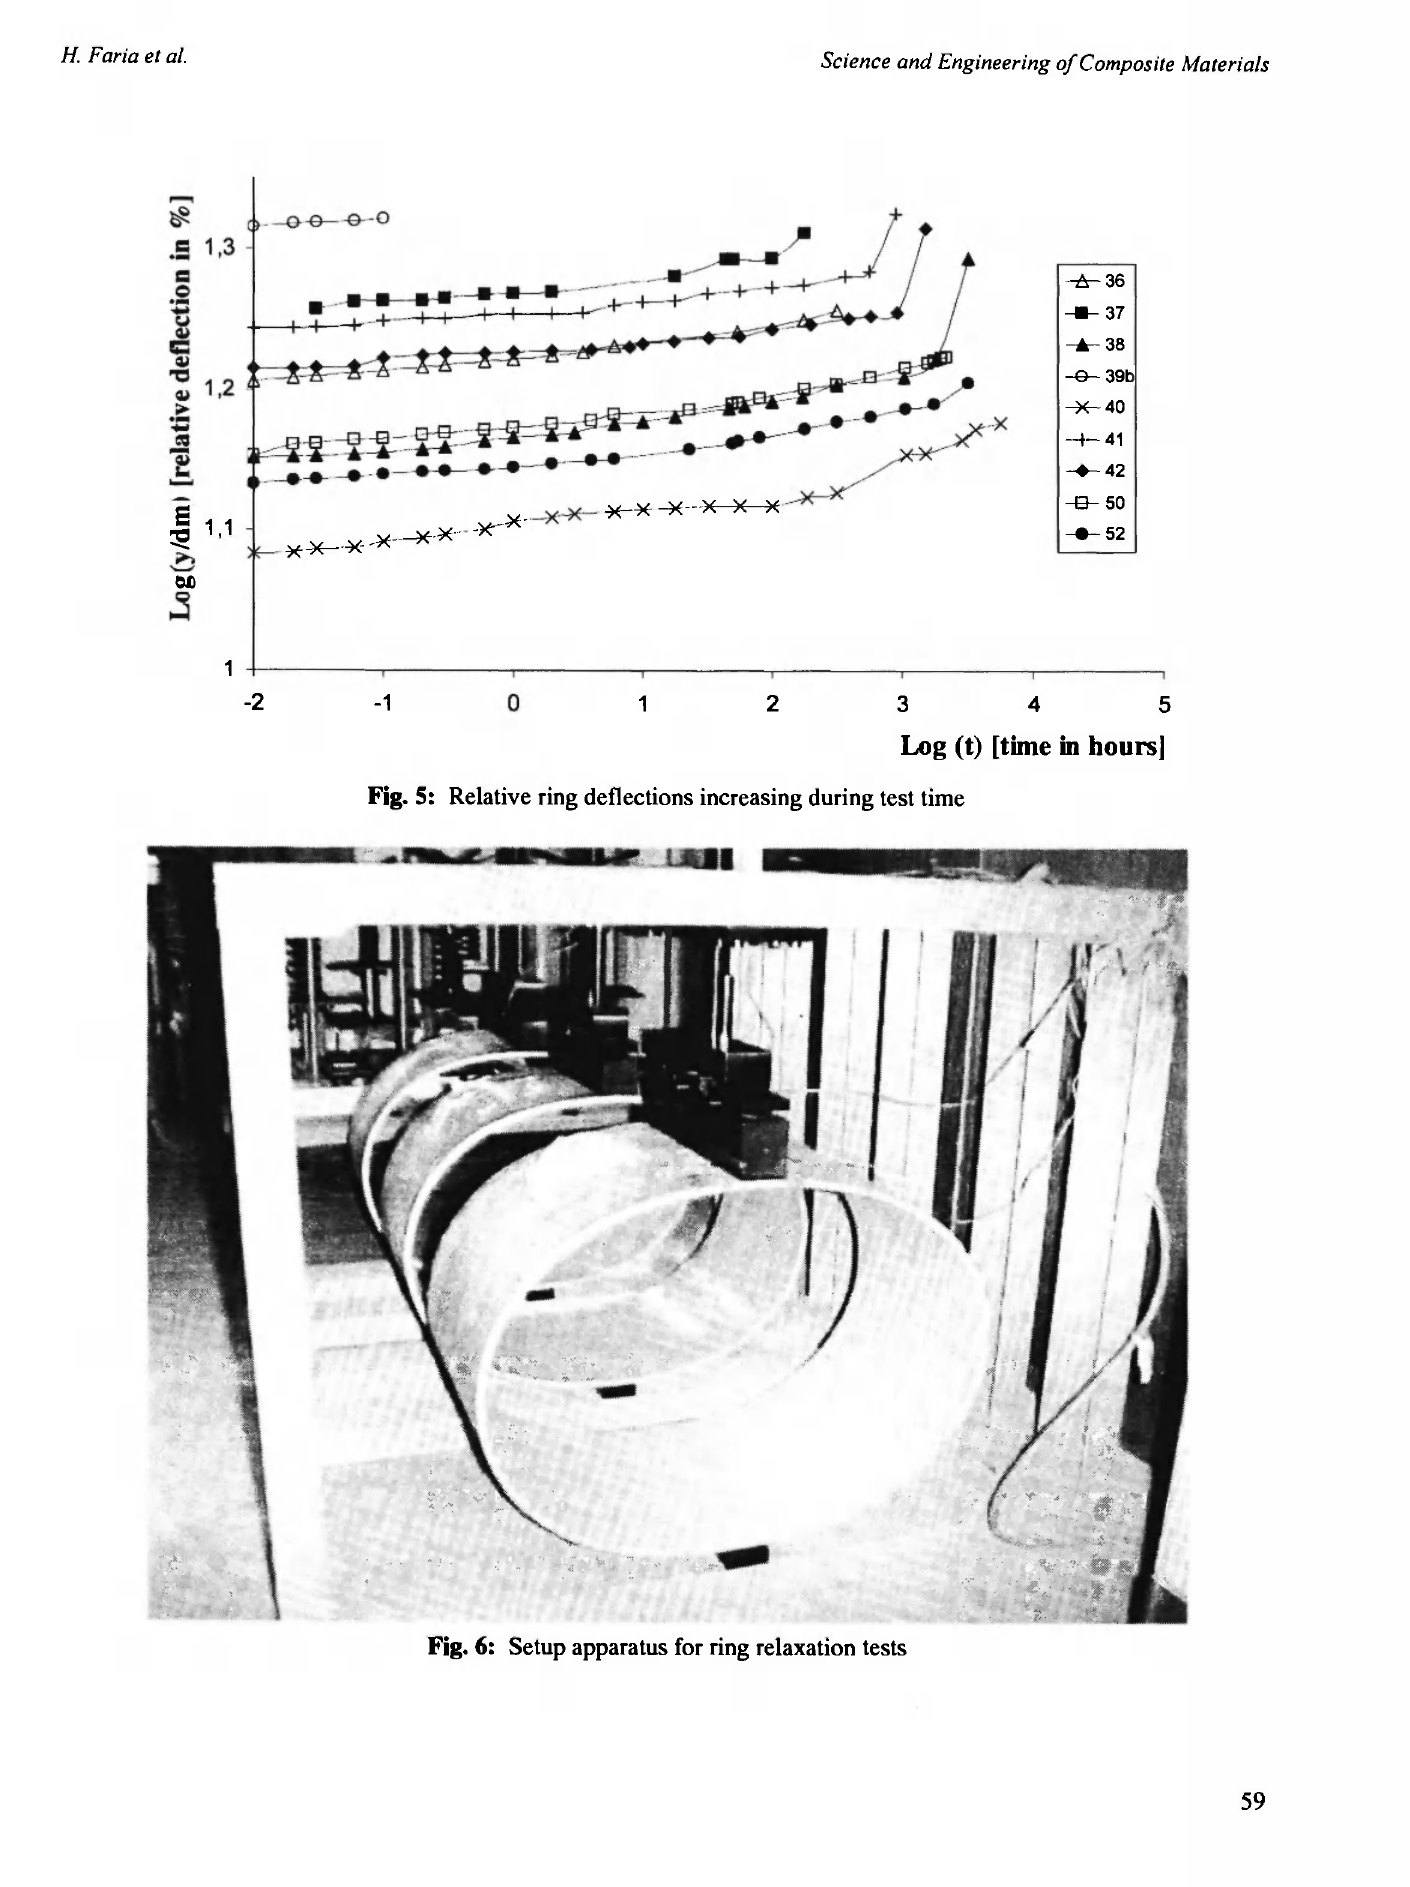
Fig. 6: Setup apparatus for ring relaxation